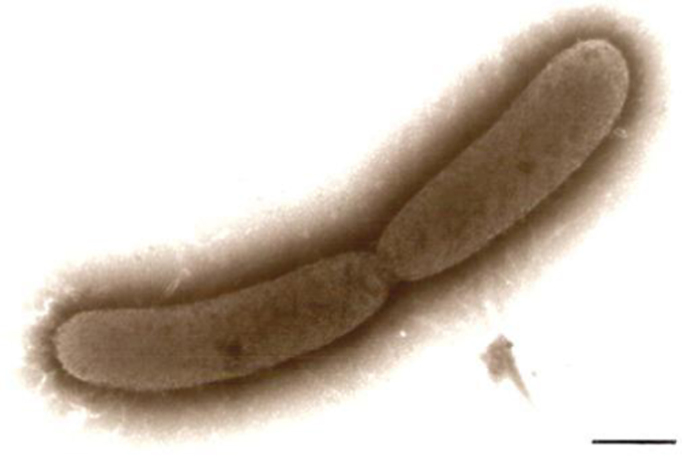
Transmission electron micrograph of negatively-stained S. olleyana undergoing cell division (Bar, 0.5 μm).